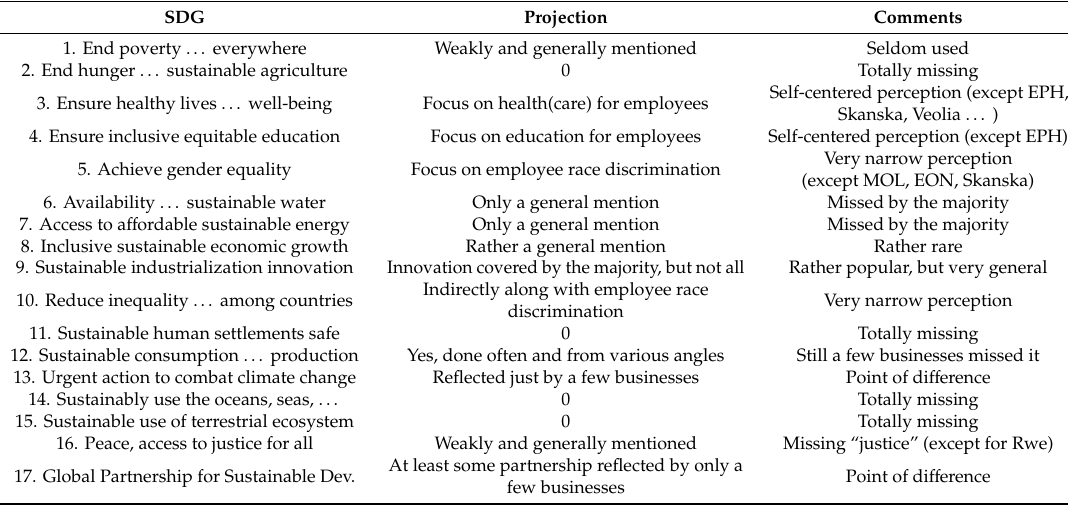
Table 7. Reality of SDGs’ popularity and